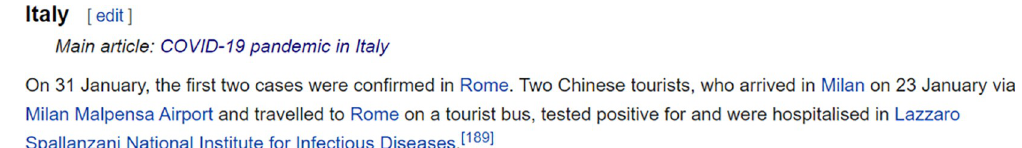
Fig 1. Screenshot of the “COVID-19 pandemic in Europe” Wiki page.